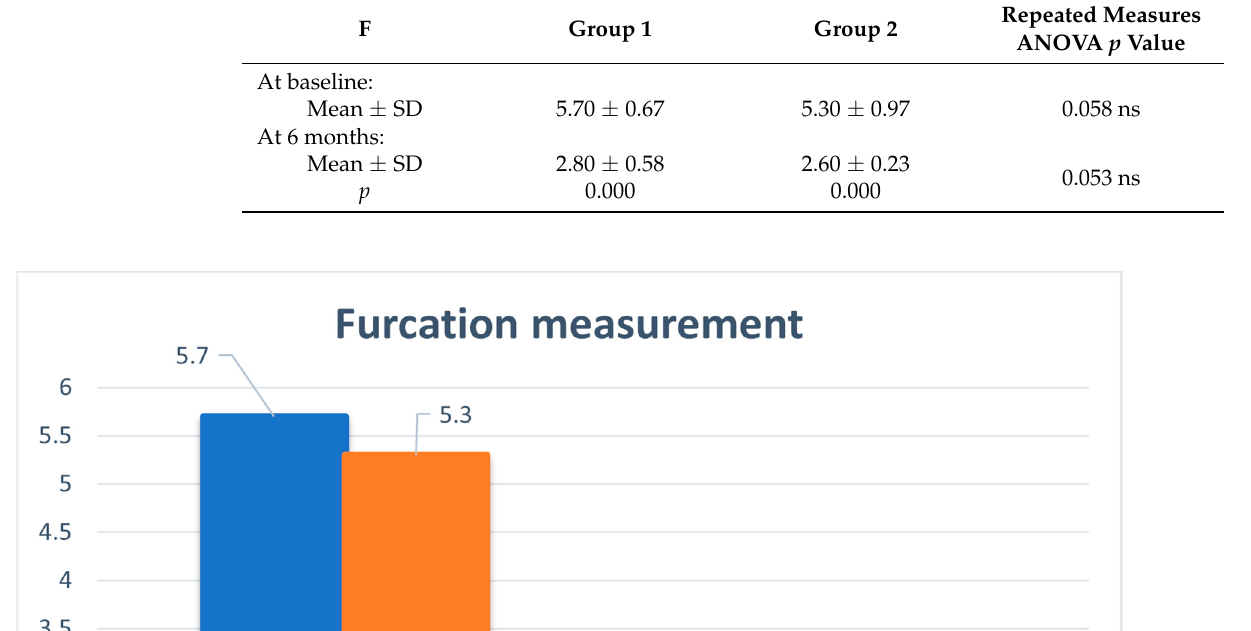
Table 1. The mean furcation assessment (F in mm) values in groups 1 and 2 at baseline and 6 months postoperative.